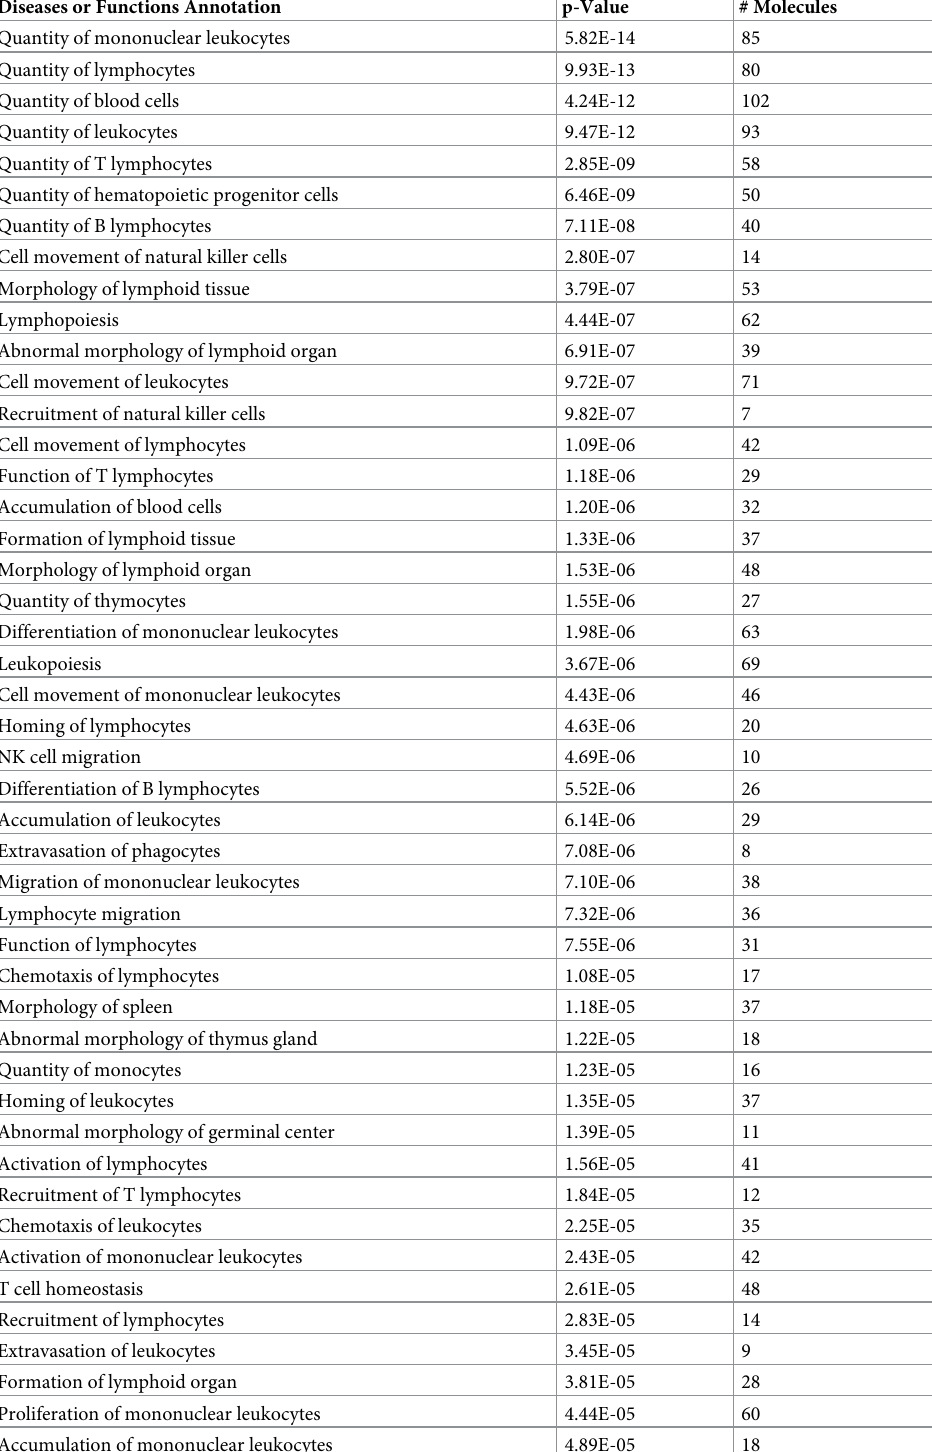
Table 3. The functions associated with hematological system development: Top 1000 FDR corrected DEGS from whole blood when frozen vs. cold conditions are compared using BH p-value (Benjamin-Hochberg corrected p- value) settings in